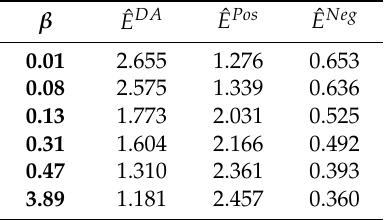
Table 2. Expected energy exchanged (MWh) for different values of β adopted from [14].